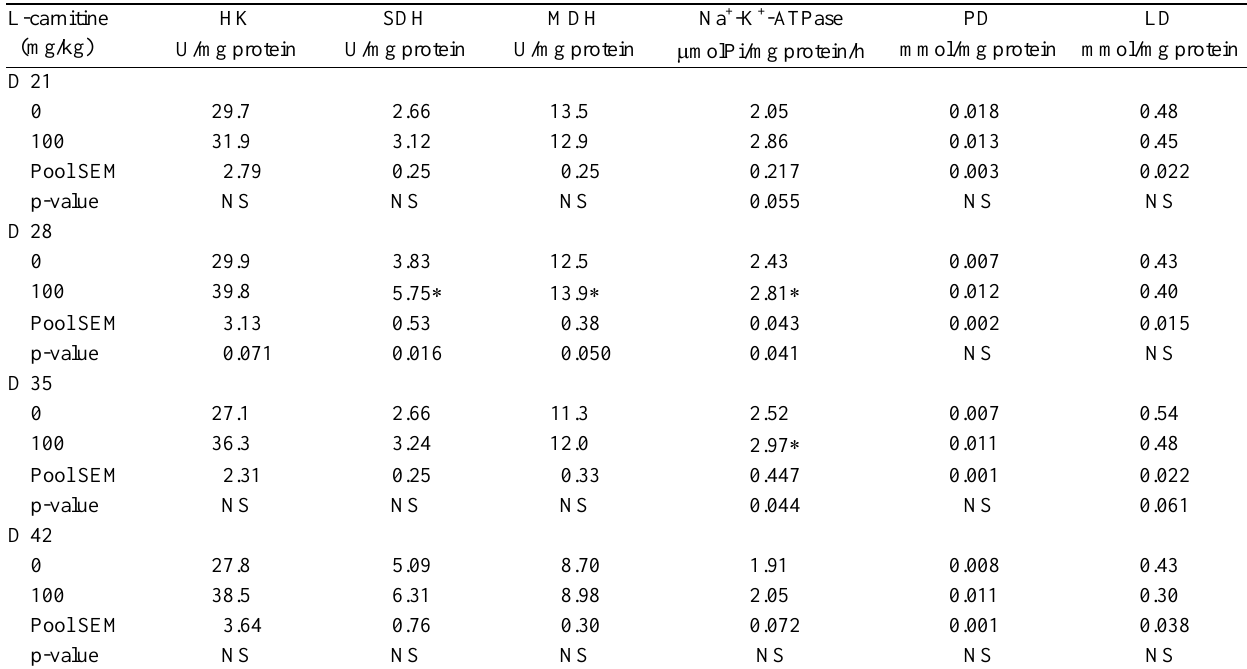
Table 5. Effect of dietary L-carnitine supplementation on liver energy metabolic parameters